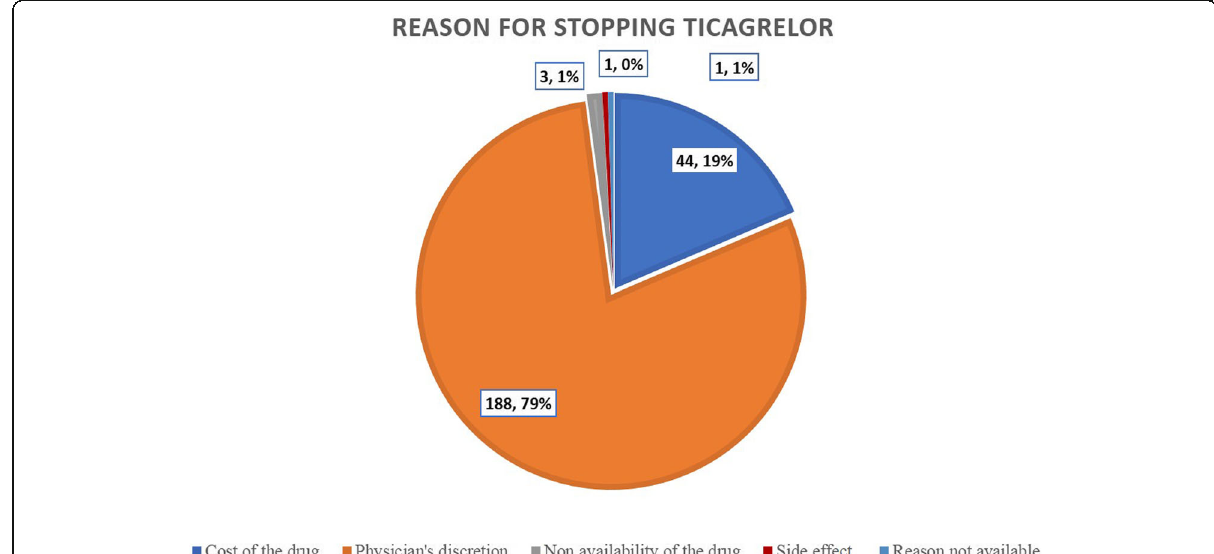
Fig. 2 Reason for stopping ticagrelor and switching-over to other P2Y12